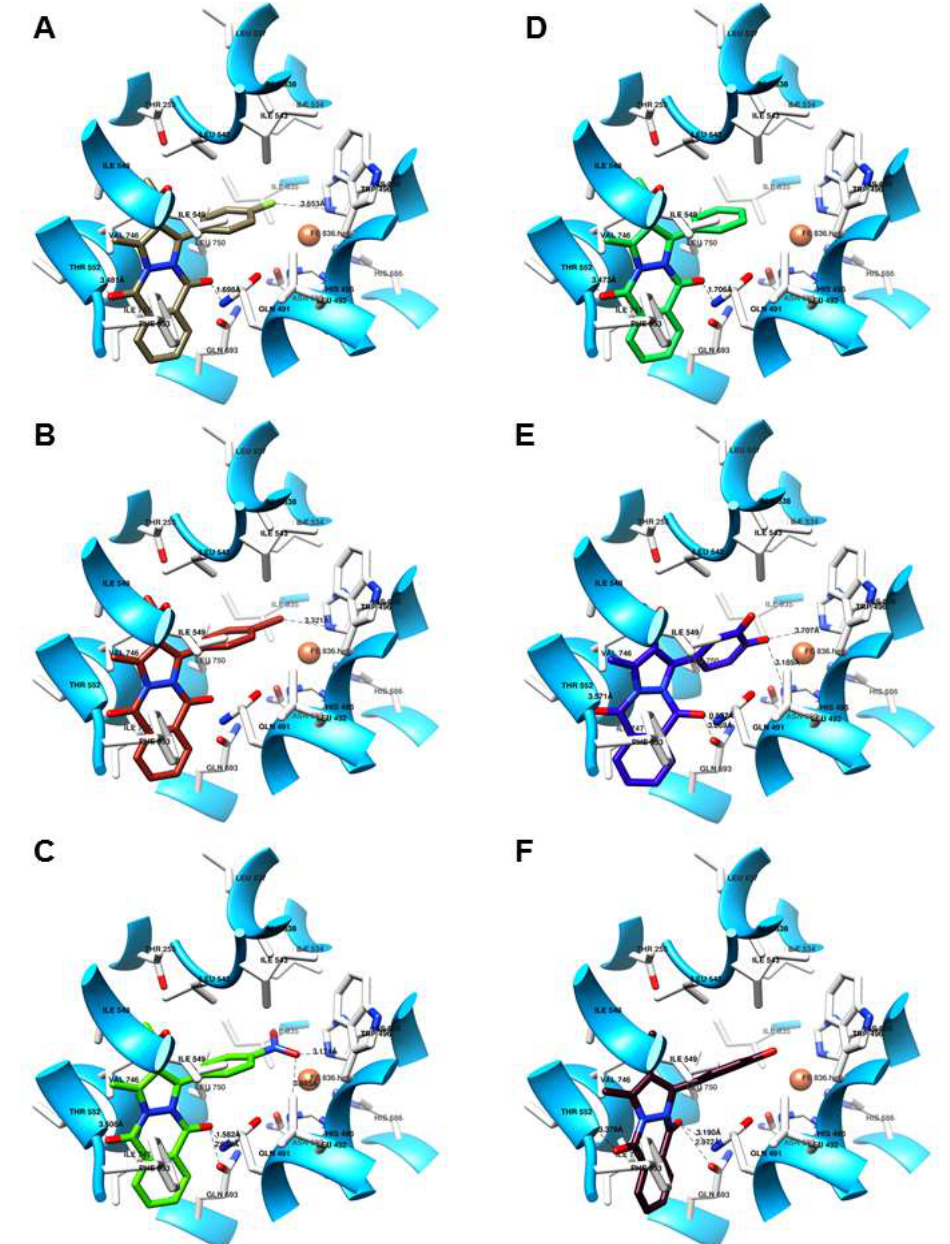
Figure 5. The bioactive conformation of PPD-4 (A); PPD-3 (B); PPD-5 (C); PPD-1 (D); PPD-7 (E); PPD-6 (F). The LOX-Ib amino acids are presented in white, the LOX-Ib ribbon is colored in blue. For the clarity purpose, only polar hydrogen atoms are